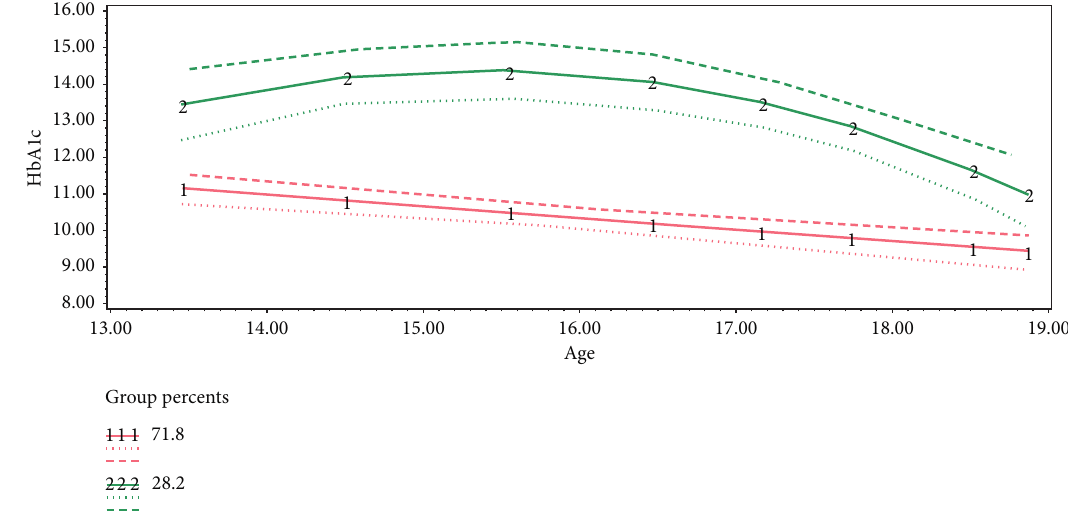
Figure 1: Longitudinal trajectories of HbA1c across adolescence (dash lines are 95%